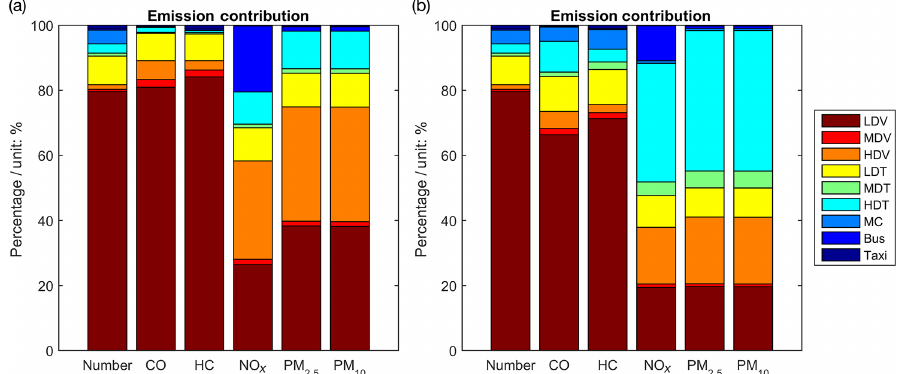
Figure 8. Emission contribution of each vehicle classification in (a) urban area and (b) suburban